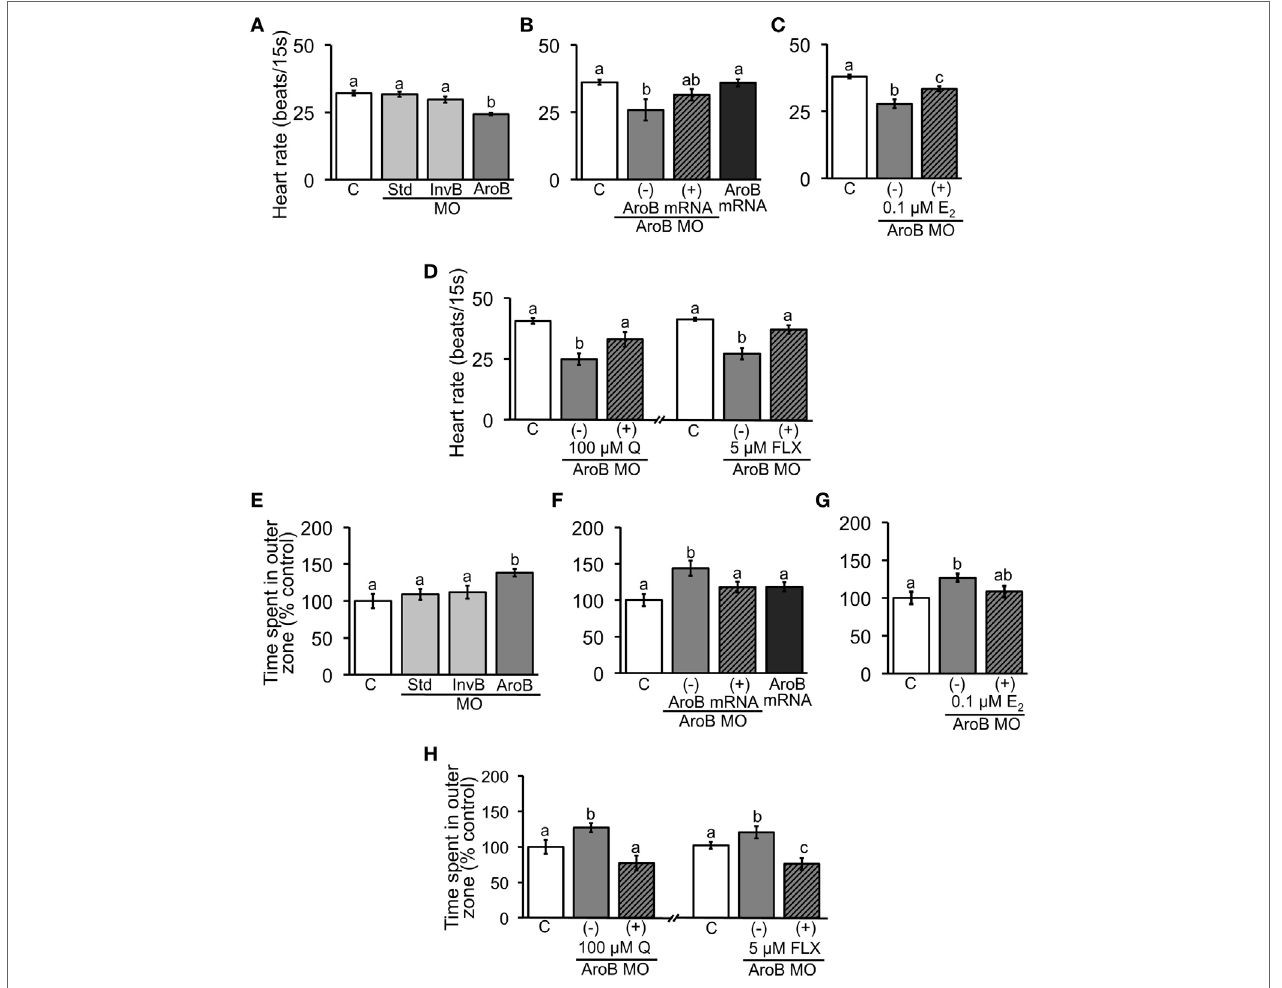
FigUre 5 | AroB MO-mediated effect on heart rate and thigmotaxis. Heart rate was measured in 2-dpf embryos; (a) injection of AroB MO and control MOs; (B,c) co-injection of AroB mRNA and exposure to E 2 , respectively, to rescue the effect of AroB MO; (D) injection of AroB MO with and without exposure to Q and FLX to examine involvement of serotonin signaling. Thigmotaxis assay was conducted using 6-dpf larvae; (e) injection of AroB MO and control MOs; (F,g) co-injection of AroB mRNA and exposure to E 2 , respectively, to rescue the effect of AroB MO; (h) injection of AroB MO with and without exposure to Q and FLX to examine involvement of serotonin signaling. Data are presented as a mean ± SEM. Different letters in each graph indicate significant differences ( p <